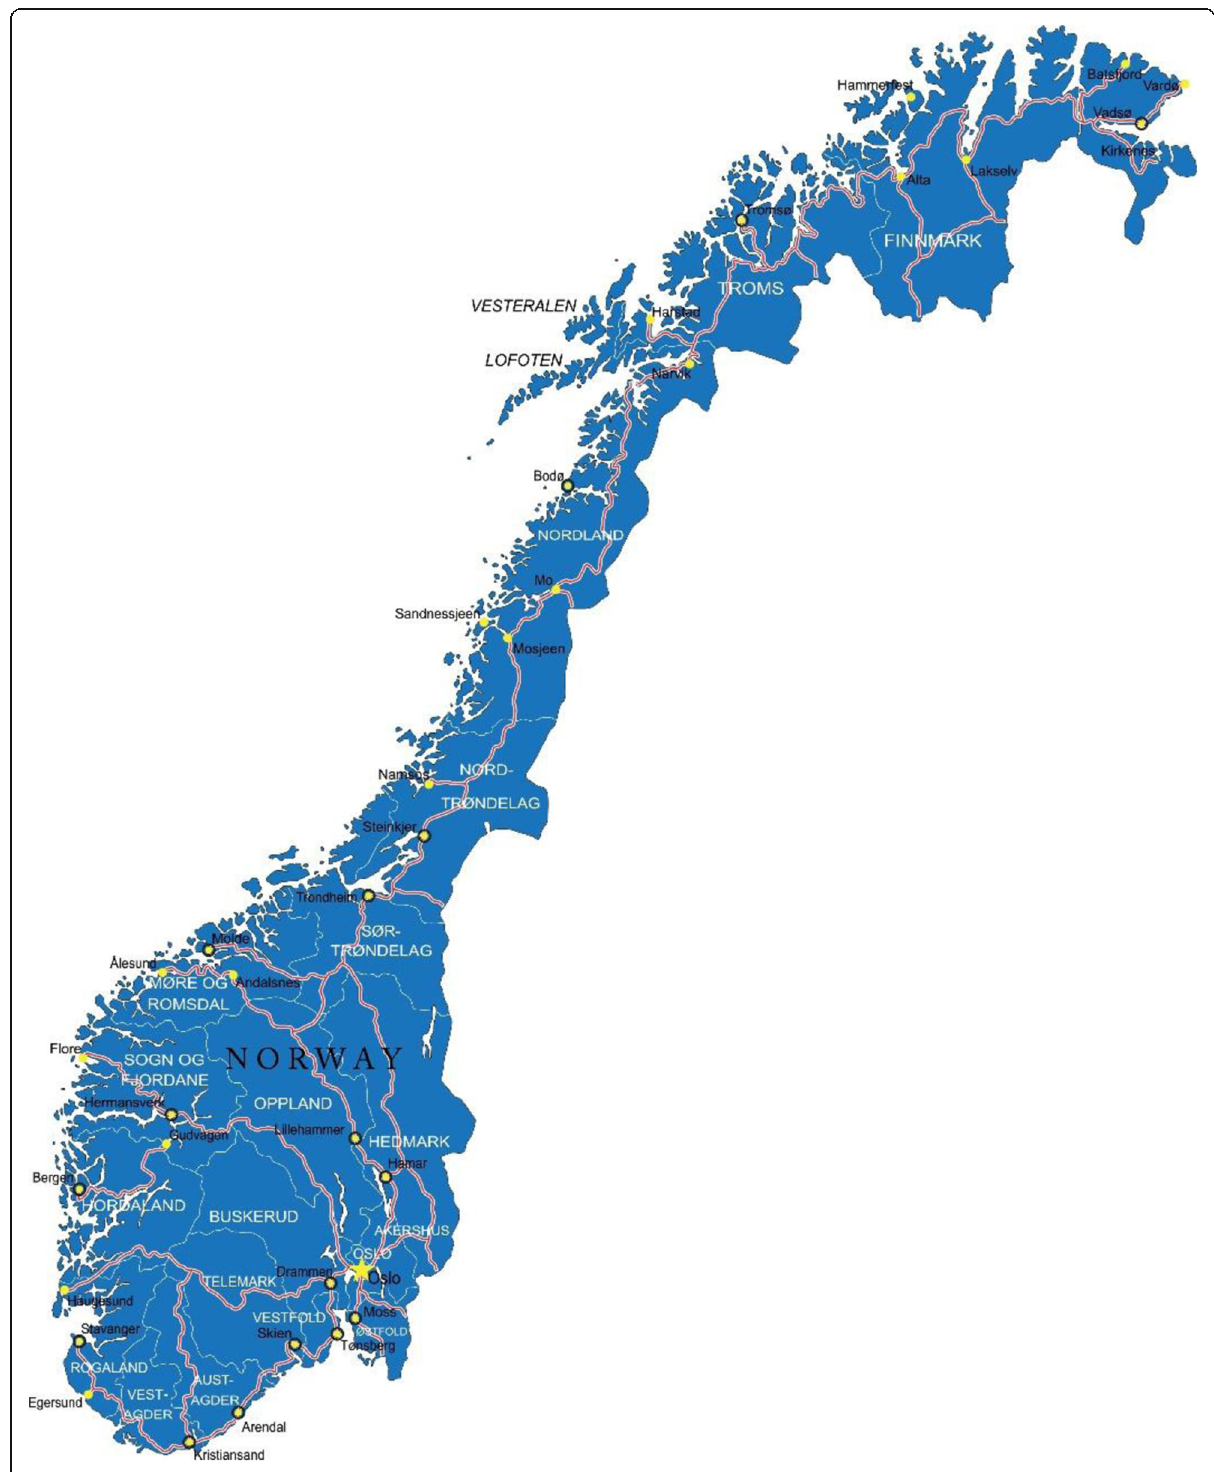
Fig. 1 The study providers for the Vanguard Study were recruited from Troms County. For the Main Study, providers were recruited from Telemark and Vestfold Counties in the south, and Finnmark and Troms Counties in the north of Norway. This map is obtained from Colorbox. Colorbox is a digital image database, which the entire UiT The Arctic University of Norway, has been granted access to, free of charge. No copyright